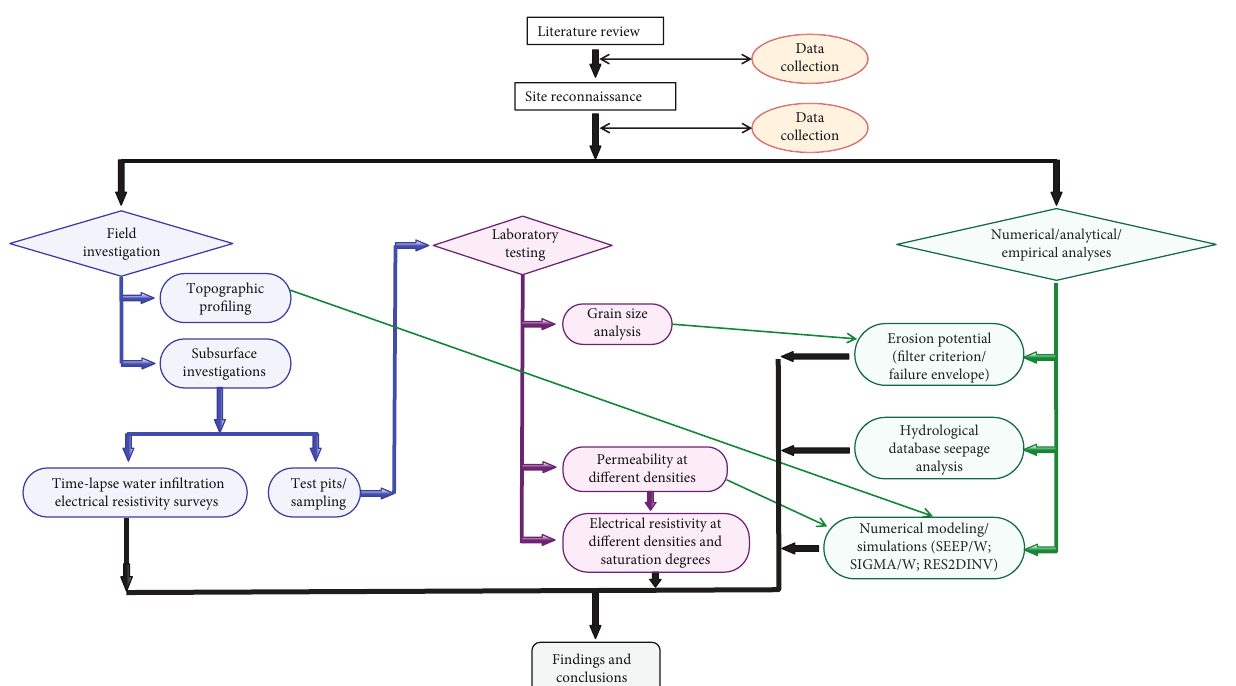
Figure 11: Flow chart of the authors ’ investigations for Hattian Bala landslide